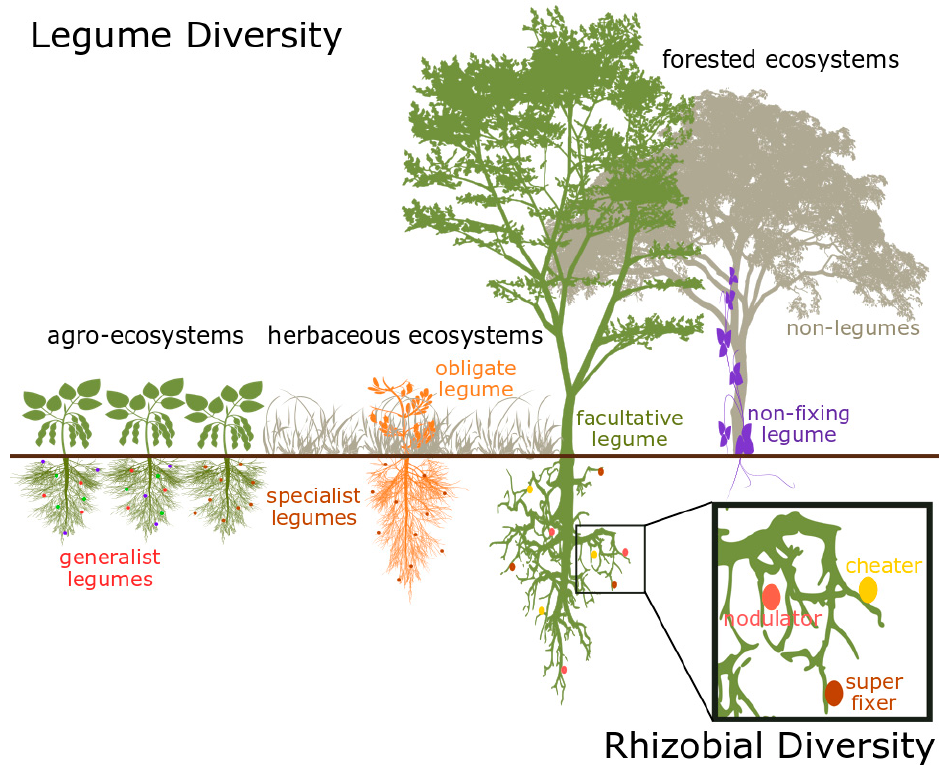
Figure 1. Functional diversity in the legume–rhizobia mutualism. Legumes occupy a variety of habitat types, such as agricultural, herbaceous, and forest ecosystems. They can also take on a range of growth forms (trees, vines, shrubs, and herbs) and substantially differ in their promiscuity with rhizobial partners (generalists vs. specialists) and their ability to regulate symbiotic nitrogen fixation (SNF) (obligate vs. facultative). Belowground, rhizobia are also functionally diverse along axes of habitat type, promiscuity, and partner e ffi cacy (e.g., nodulators, cheaters, super fixers, etc.). This substantial functional diversity can impact the contribution that nitrogen (N) fixers make to ecosystem function through a variety of biodiversity-ecosystem function (BEF)